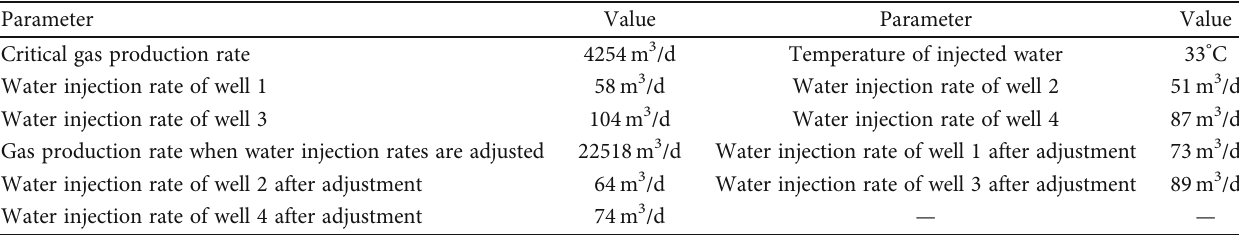
Table 4: Optimal parameter values of i-SAPSO